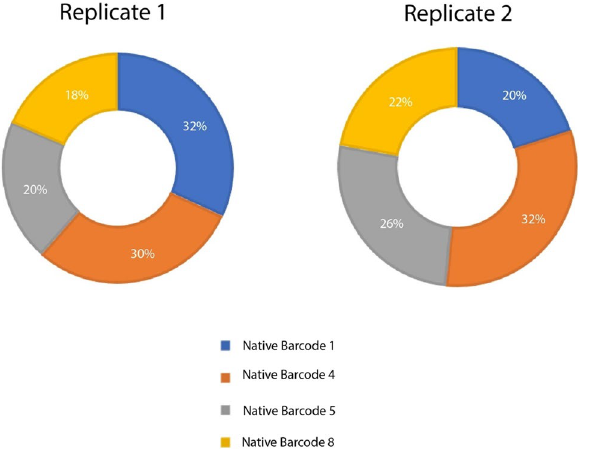
Figure 6. Native Barcode reads demultiplexed from LoRTIS data. The circular plots represent the total number of transposon specific sequences containing reads that were demultiplexed from LoRTIS data. Replicate 1 had reads from all four Native Barcodes (NBDs): 32% of reads were from NBD1 (blue), 30% from NBD4 (brown), 20% from NBD5 (grey) and 18% from NBD8 (yellow). Replicate 2 had reads from all four NBDs: 20% from NBD1 (blue), 32% from NBD4 (brown), 26% from NBD5 (grey) and 22% from NBD8